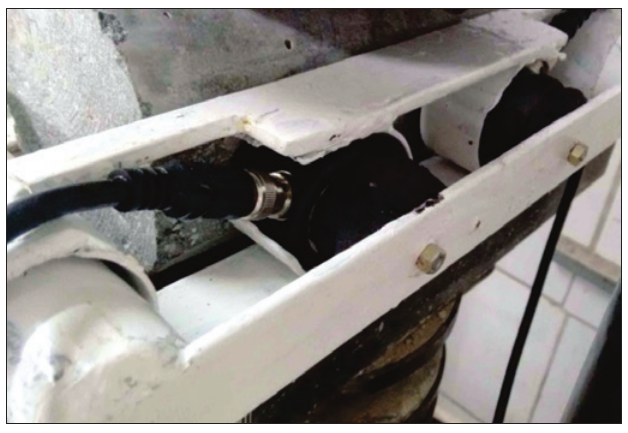
Detalhe da fixação dos transdutores para o ensaio de tração à compressão